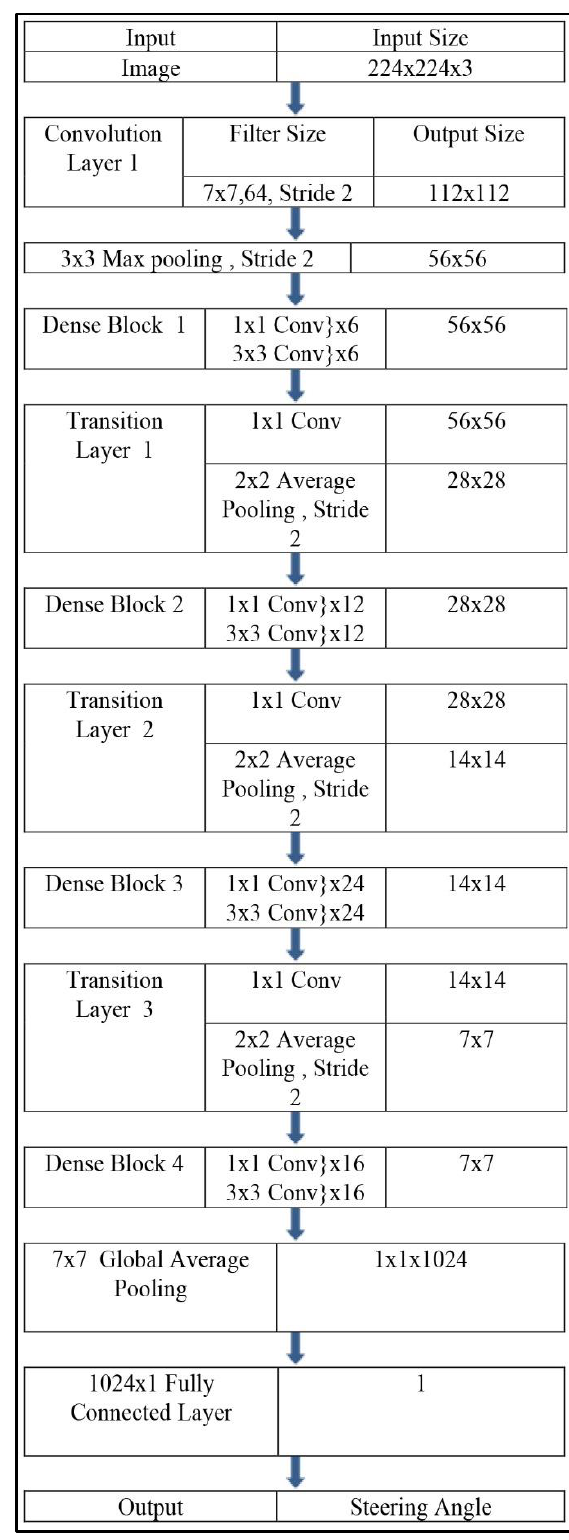
Fig. 3. DenseNet121